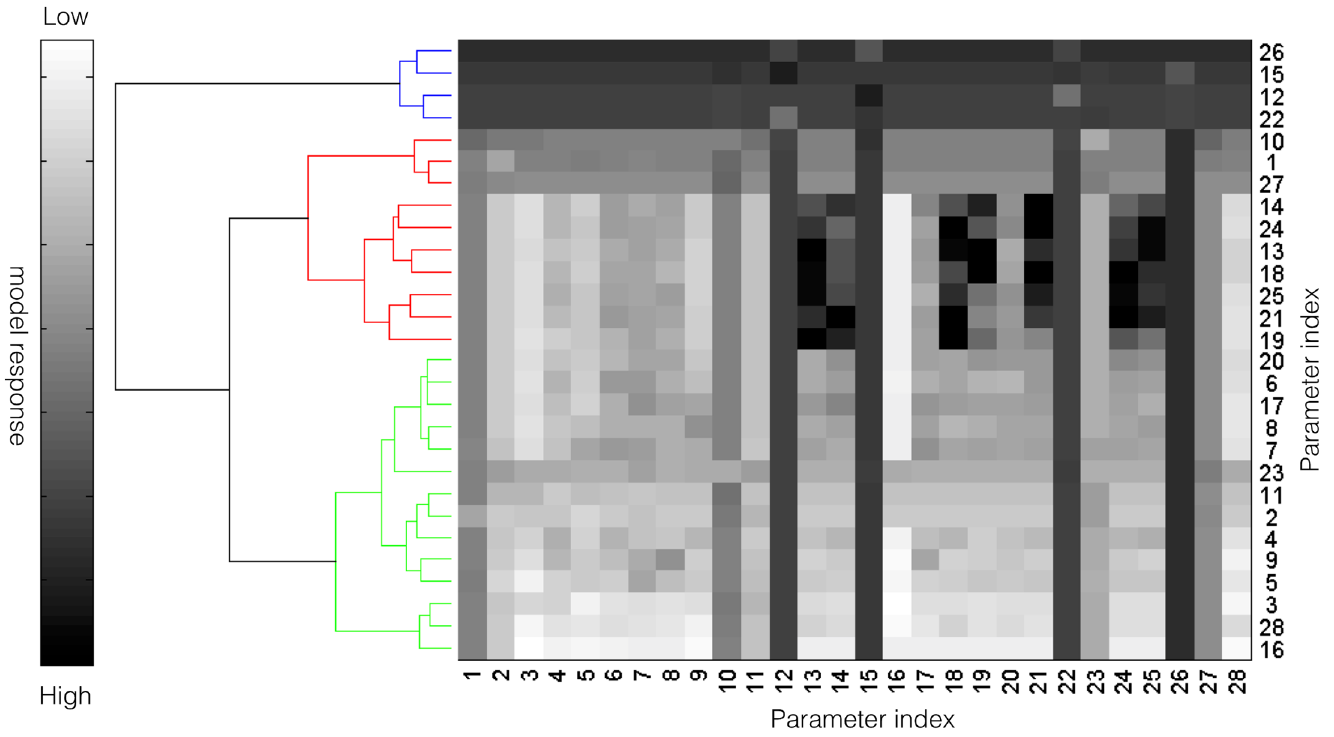
Fig 5. Pairwise sensitivity and clustering of complement model parameters in the presenceof 1 mg/ml zymosan. The responseof the complement model was calculatedfor each parameter combination followinga 10% increasein parameter combinations in the presenceof 1 mg/ml zymosan. The model parameters were clusteredinto high (blue), medium (red) and low (green)response clusters based upon the euclidian distance betweenthe perturbedand nominalsystem state (no perturbation).